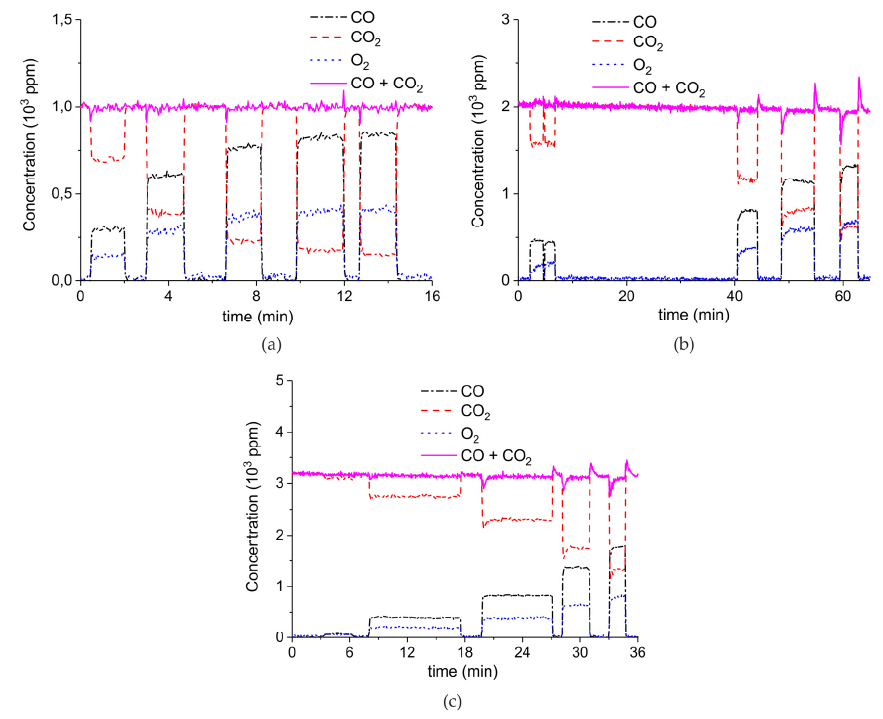
Figure A10. Concentration of the products of CO 2 dissociation on 100mg α -Al 2 O 3 , particle size of 250– 300 μ m, as function of time at 630 °C, flow rate of 90 mL/min. The fed CO 2 concentration is 1000ppm ( a ), 2000ppm ( b ) , and 3200ppm ( c ); the plasma powers are 0.6, 1.6, 3.1, 4.8, and 7.2 W (a); 0.7, 1.8, 4.1, and 5.6 W (b); and 0.5, 1.5, 3.1, and 4.9 W (c). The plasma is applied for a few minutes and then turned